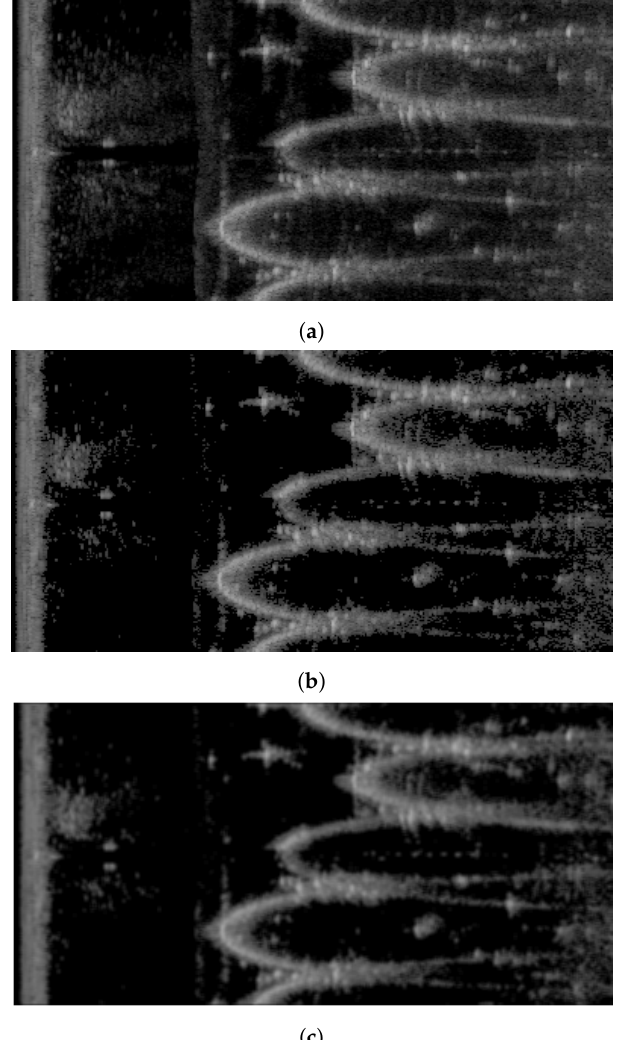
Figure 12. Intermediate results of image pre-processing routine applied to image 6 of dataset 2. ( a ) Original image, ( b ) image after threshold operation, and ( c ) image after filtering